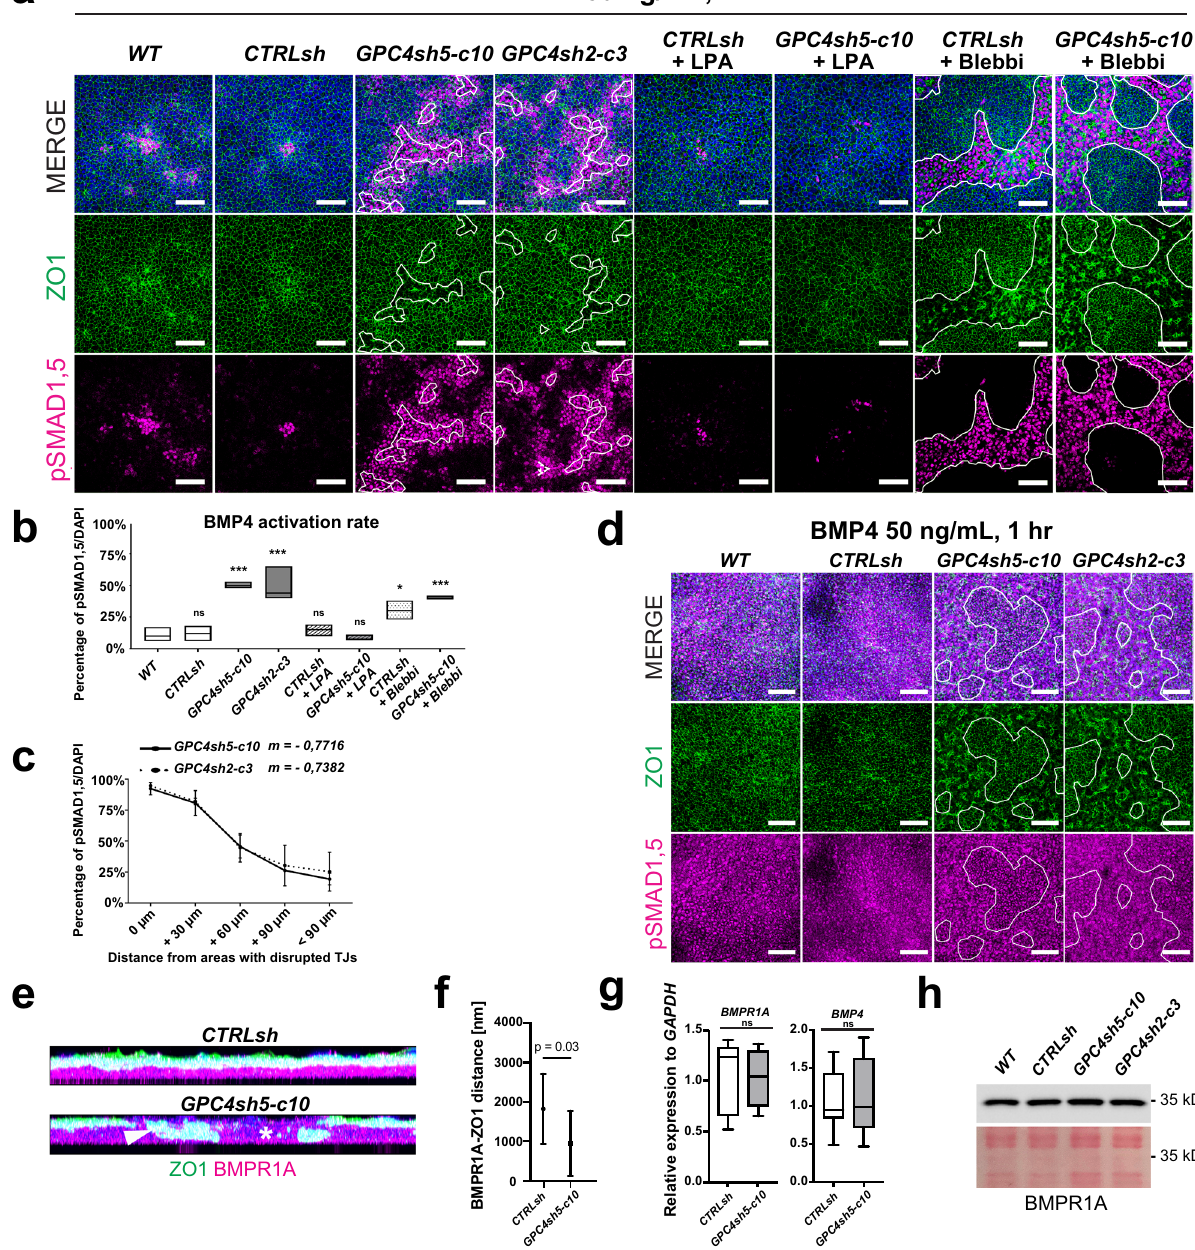
Fig. 6 | Disruptionofepithelial integrityenablesactivationofTGF- β signaling. a CulturesofWT,CTRLsh,GPC4sh5-c10andGPC4sh2-c3hiPSCstreatedornotwith LPA or Blebbi were stimulated for 1h with BMP4 (50ng/mL), and analyzed for pSMAD1,5 (magenta) and ZO1 (green) proteins by immunocytochemistry. Dashed areashighlight zones with disrupted TJs, n =3. Scale bar: 100 μ m. b Percentages of pSMAD1,5 positive cells quanti fi ed from staining in a . Box plots represent the medianwithminandmaxvalues, n =3. c PercentagesofpSMAD1,5positivecellsas a function of distance from zones with disrupted TJs quanti fi ed from staining in a . 0 μ m indicates cells located within zones with disrupted TJs, +30 μ m, +60 μ m, +90 μ m and <+90 μ m indicate cellslocated at0 to 30 µ m, 30 – 60 µ m,60 – 90 µ m or >90 µ m away from zones with disrupted TJs, respectively. Data are represented as mean±SD, n =3. d Immuno fl uorescence analysis of pSMAD1,5 (magenta) and ZO1 (green) in the indicated hiPSC lines grown in transwell plates and stimulated from the basal side with BMP4 (50ng/mL). Outlined areas highlight zones of disrupted